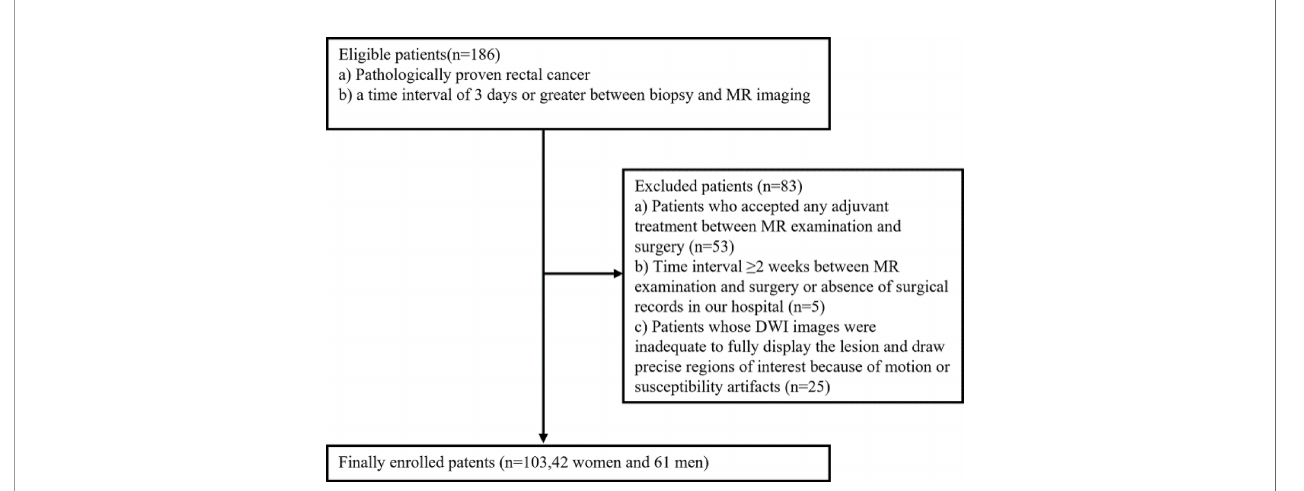
FIGURE 1 | Flowchart of the